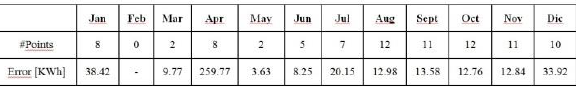
Table 1: Average production error and number of points aggregated on a monthly time